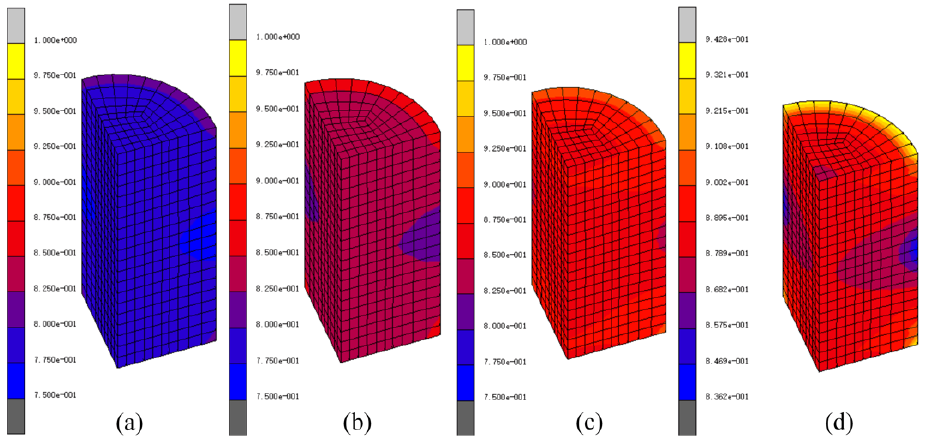
Figure 24. Relative density distributions in compact at compaction pressure of 200 MPa and for various